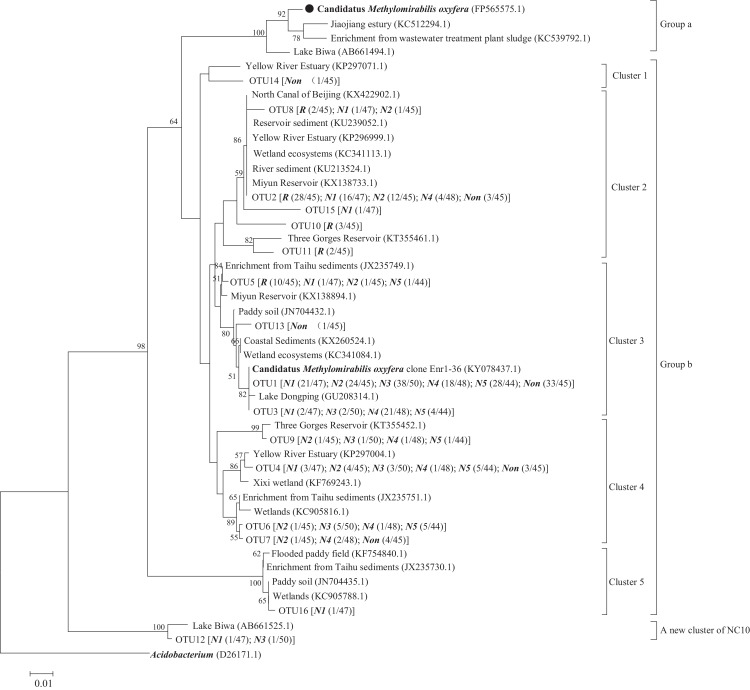
Neighbor-joining phylogenetic tree of M. oxyfera-like bacterial 16S rRNA gene sequences in rhizosphere and non-rhizosphere sediments of P. crispus.R and Non represent sediment samples in root compartment and non-rhizosphere, respectively. N1–N5 represent sediment samples taken from one to five mm of near-rhizosphere sub-compartments. The numbers in the brackets represent the ratio of the number of sequences out of the total number in the corresponding interlayer. The numbers at the nodes are percentages that indicate the levels of bootstrap support based on 1,000 replicates, and only percentages more than 50% are shown. The scale bar represents 1% sequence divergence.